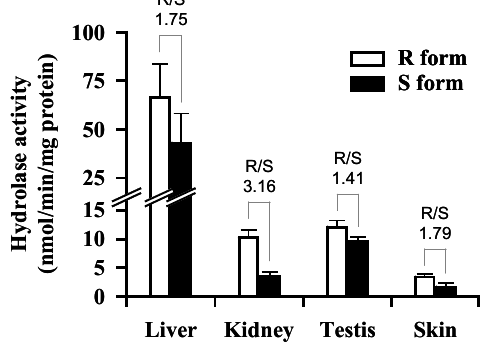
Figure 4. Formation of R - and S -PL by hydrolysis of racemic caproyl-PL in S9 fraction of several rat tissues. Racemic caproyl-PL (100 μ M) was hydrolyzed in the S9 fraction from several rat tissues diluted with 50 mM HEPES buffer (pH 7.4). Open and filled columns show the hydrolase activity for R and S forms, respectively. Each value represents the mean ± S.D. ( n =